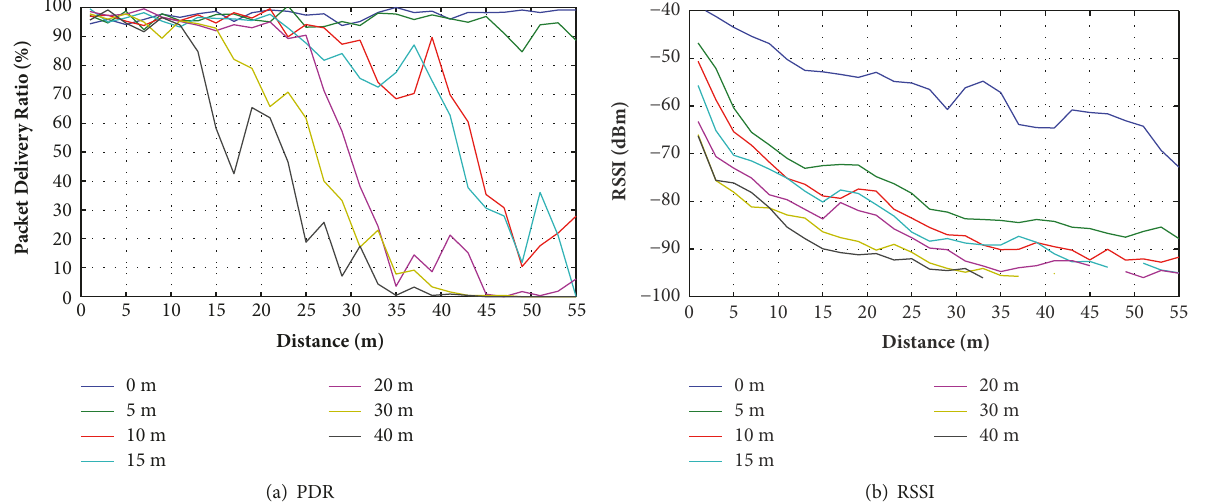
are similar to the results from real blind corner